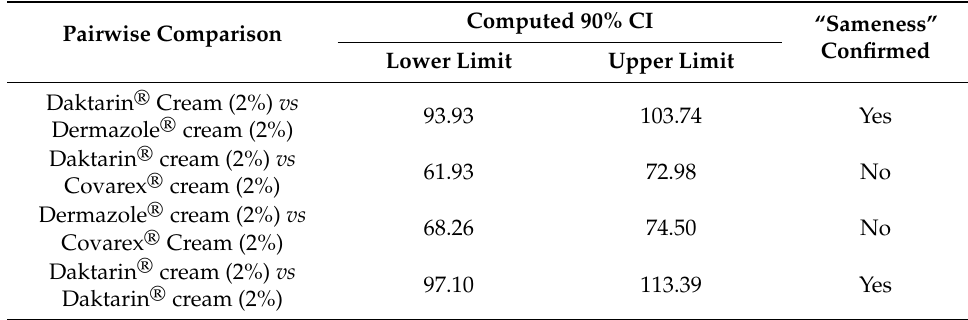
Table 4. Computed 90% CI for the comparative in vitro release testing (IVRT) of the marketed generic products against the reference product.